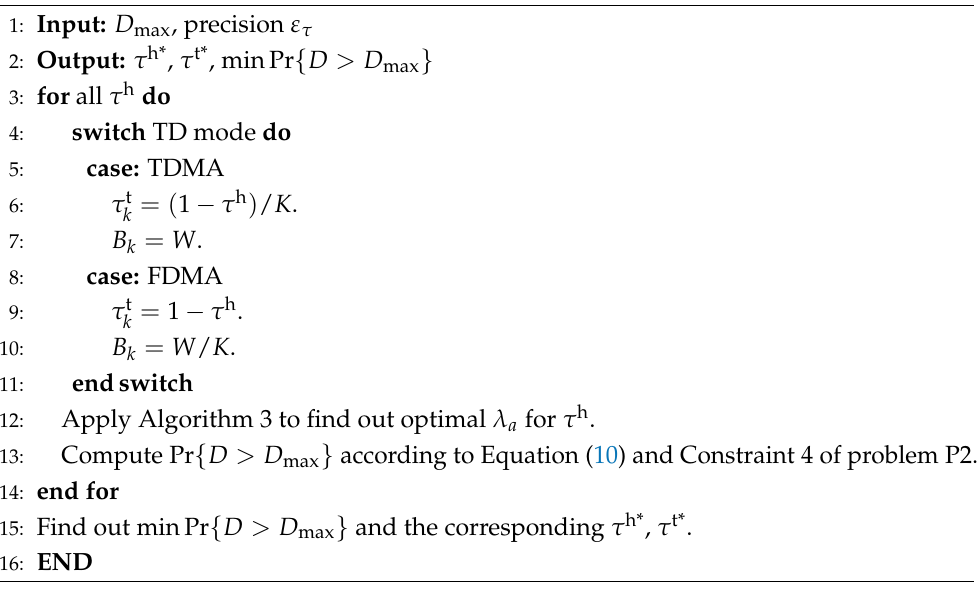
Algorithm 4 System time allocation scheme